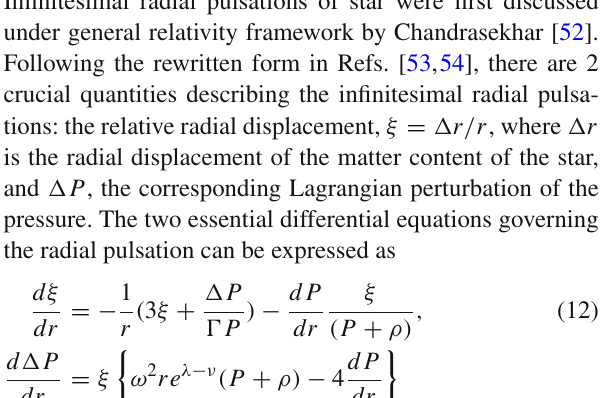
the independence of (cid:3) s of the compactness C , all MQSs with any (cid:3) s degenerate on the same